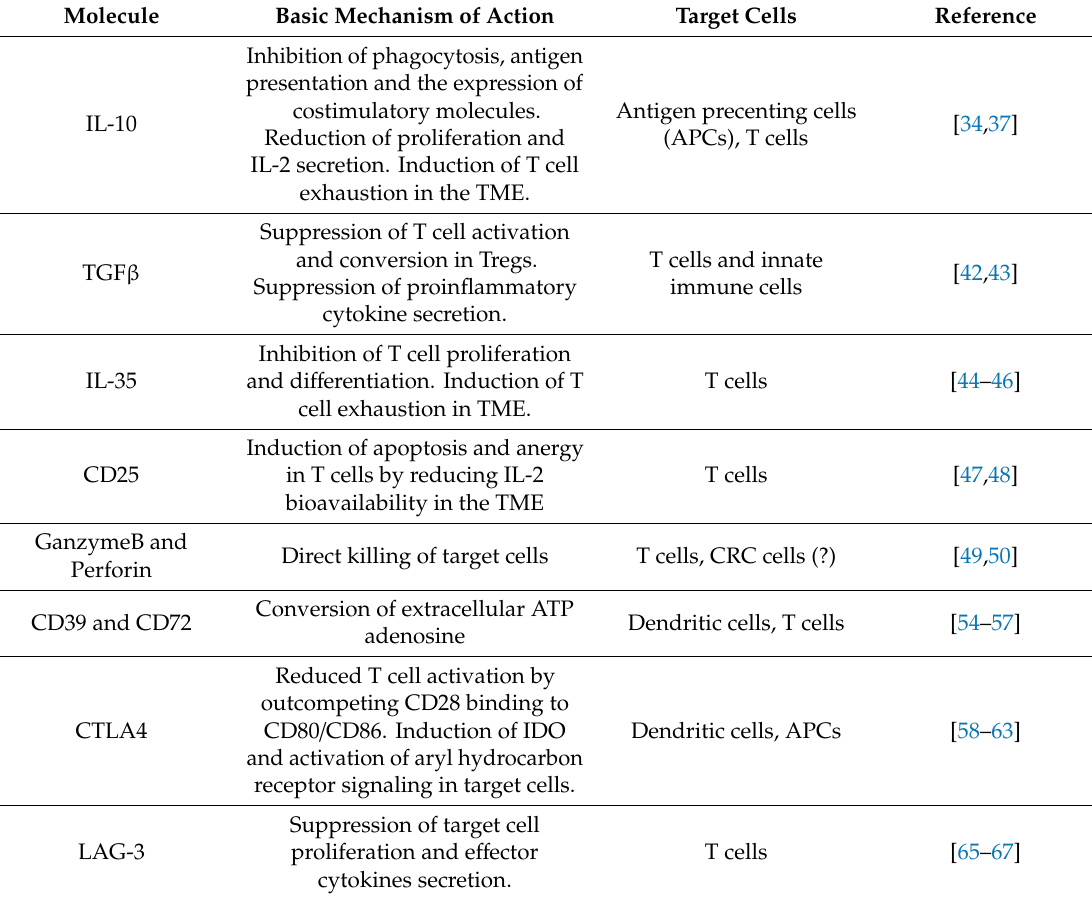
Table 1. Summary of molecule, mechanism of action and target cells operating in